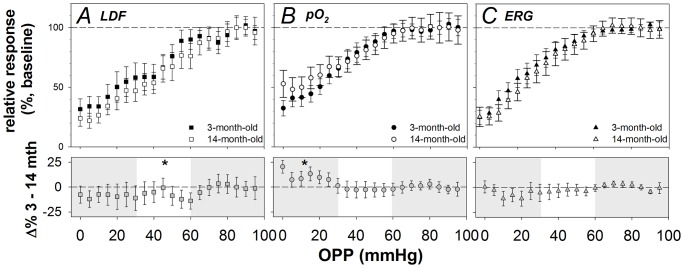
Effects of age on LDF, pO2 and ERG during OPP challenge.Simultaneous measurement of blood flow (A), vitreal oxygen tension (B) and function (C) during step-wise IOP elevation in 3-month (n = 14, unfilled symbols) and 14-month-old (n = 16, filled symbols) rats reveal differences in sensitivity between measures (average ± SEM) during stress. Blood flow was most sensitive to OPP challenge, followed by oxygen and ERG, with the latter two parameters showing similar sensitivity. The lower panels show the residuals between the 3- and 14-month-old (3–14 m.o.) for the corresponding measure in the upper panel. The shaded areas indicate the high OPP (OPP: 95–65 mmHg) and low OPP phases (25–0 mmHg) while the unshaded area in between represents the moderate OPP phase (60–30 mmHg). The asterisks denote significance of P<0.05 for the summed residual for the given phase. Older animals showed unexpectedly better blood flow regulation in the moderate OPP range, while younger animals show better oxygen tension regulation in the low OPP range. There was no difference in function during OPP challenge between these age groups.